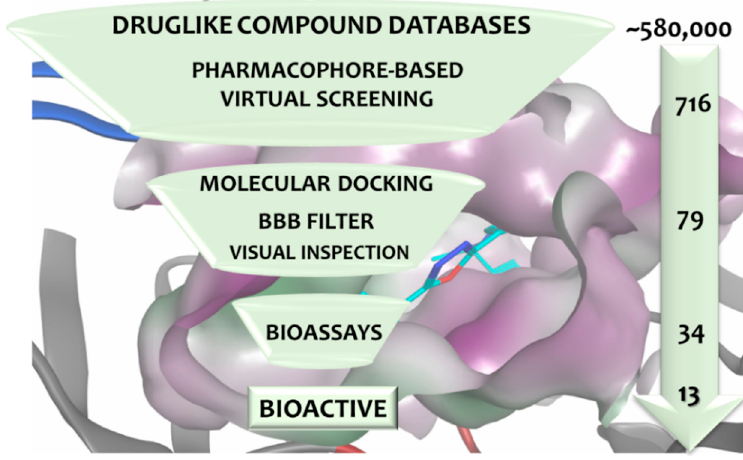
Figure 1. The virtual screening (VS) workflow applied to identify novel BACE1 ( β -site APP cleaving enzyme 1) hit inhibitors. The number of compounds remaining after filtering at each stage is listed.